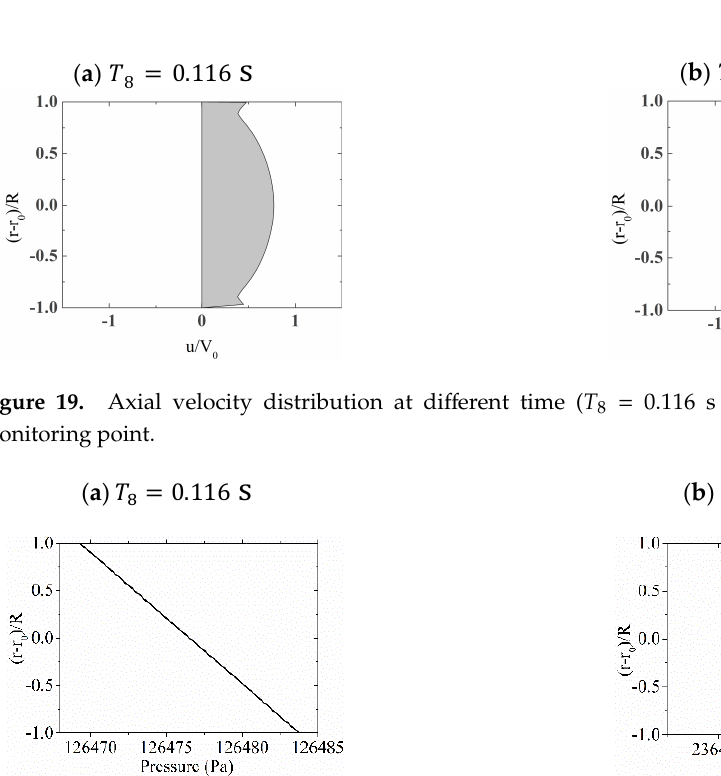
( c ) 𝑇 7 = 0.108 s Figure 17. Local pressure distribution at S1 monitoring position of different time ( 𝑇 5 = 0.092 s , 𝑇 6 = 0.1 s , and 𝑇 7 = 0.108 s ). Pressure (Pa) ( a ) 𝑇 5 = 0.092 s ( b ) 𝑇 6 = 0.1 s ( c ) 𝑇 7 = 0.108 s Figure 18. Pressure field evolution on the axis plane of the pipeline ( 𝑇 5 = 0.092 s , 𝑇 6 = 0.1 s , and 𝑇 7 = 0.108 s ). Stage 4: Figures 19 and 20 are respectively the axial velocity distribution and local pressure distribution at the S 1 monitoring position of different time, and Figure 21 is the pressure field evolution on the axis plane of the pipeline in this stage. When the pressure increase wave generated at the upstream reservoir in the fourth stage reaches the S 1 monitoring position (Figure 21a, 𝑇 8 = 0.116 s = 𝑇𝑐 + 3.27 × 𝐿/𝑎 ), the pressure head at S 1 position is 12.91 m, the velocity at the wall region is positive Figure 19a, with average axial velocity 𝑈̅ = 0.148 m/s ; the local pressure difference is 14.5 Pa (Figure 20a), the average pressure on S